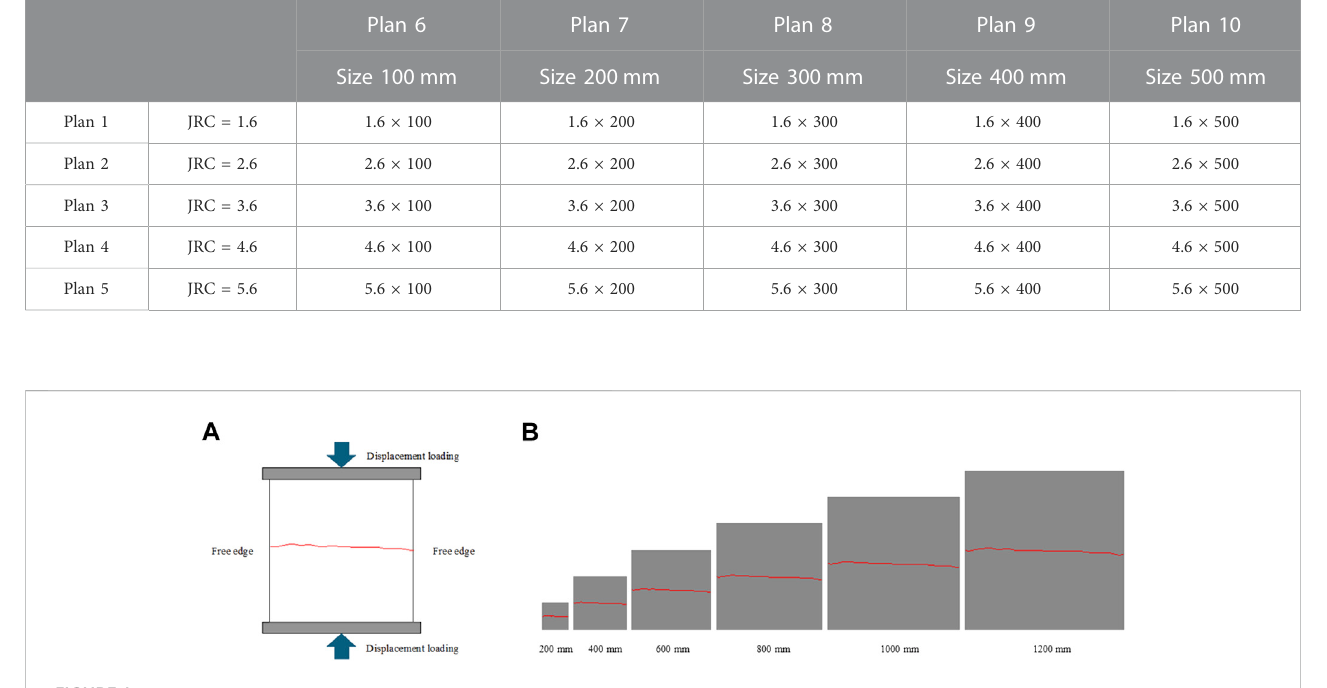
FIGURE 1 The loading and numerical models. (A) Loading method, (B) numerical models.